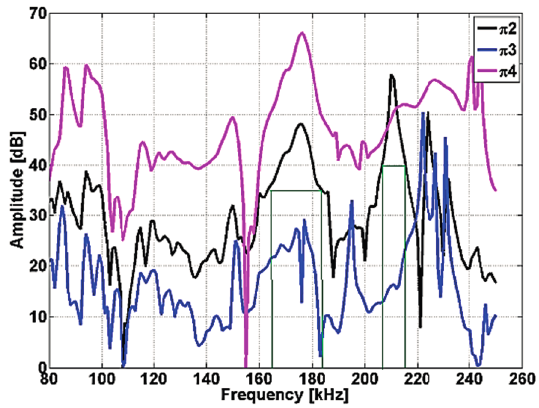
Figure 8. Resonance ultrasound spectra for samples π 2– π 4.